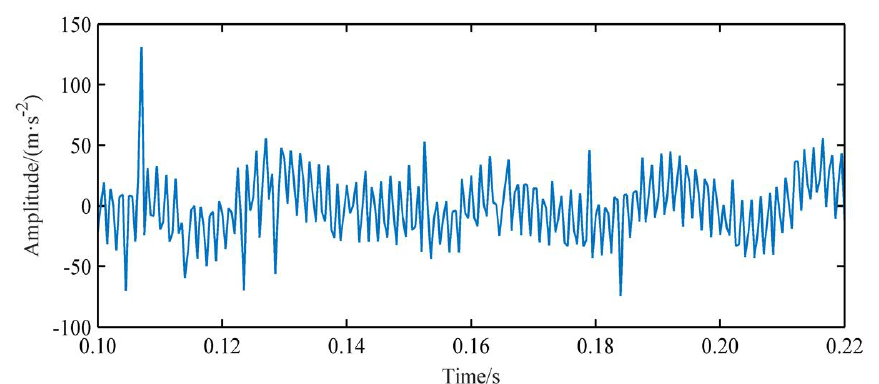
Figure 7. Time-domain response of vertical axle-box acceleration due to 24th-order wheel polygon with OOR amplitude of 0.02mm at 300 km·h − 1 .